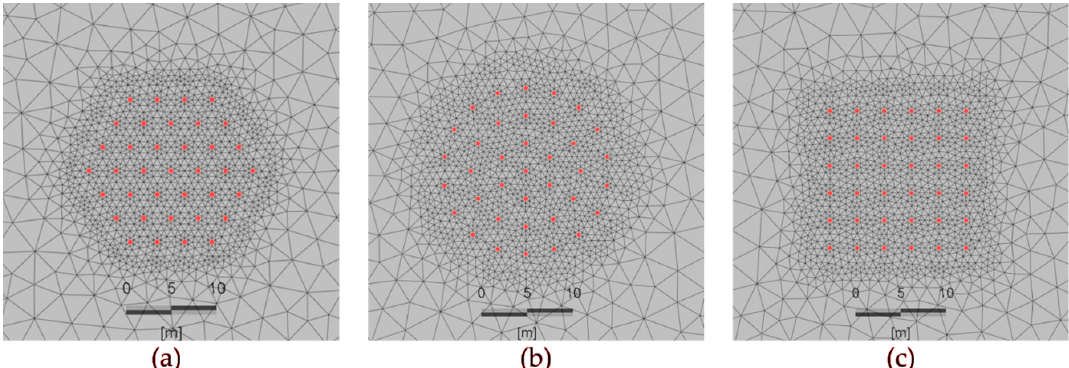
Figure 3. Top view on FEFLOW benchmark models with red markers for BHE positions: ( a ) hexagonal storage with 37 BHEs; ( b ) circular storage with 37 BHEs; ( c ) rectangular storage with 36 BHEs.